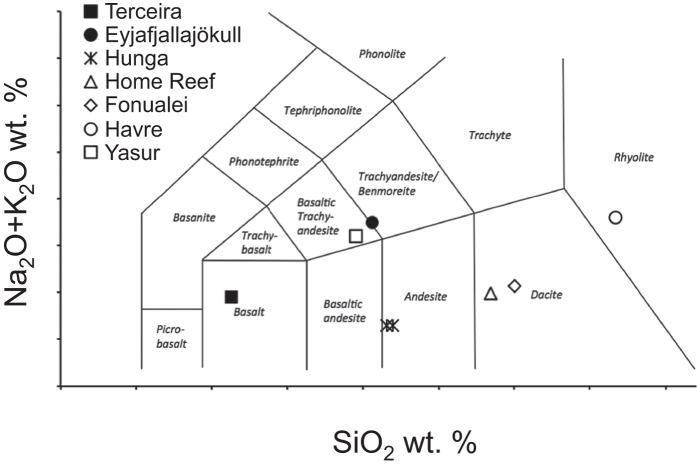
Plot of total alkalis versus silica illustrating the bulk composition of the island arc ([open symbols]Vanuatu: Van A1; Tonga: HH09-01, HH09-02, HR06, and F0805; and Kermadec: PC) and ocean island ([closed symbols] Azores: Serreta; Iceland: EJ-1) samples analyzed here.Data are from Table 1.